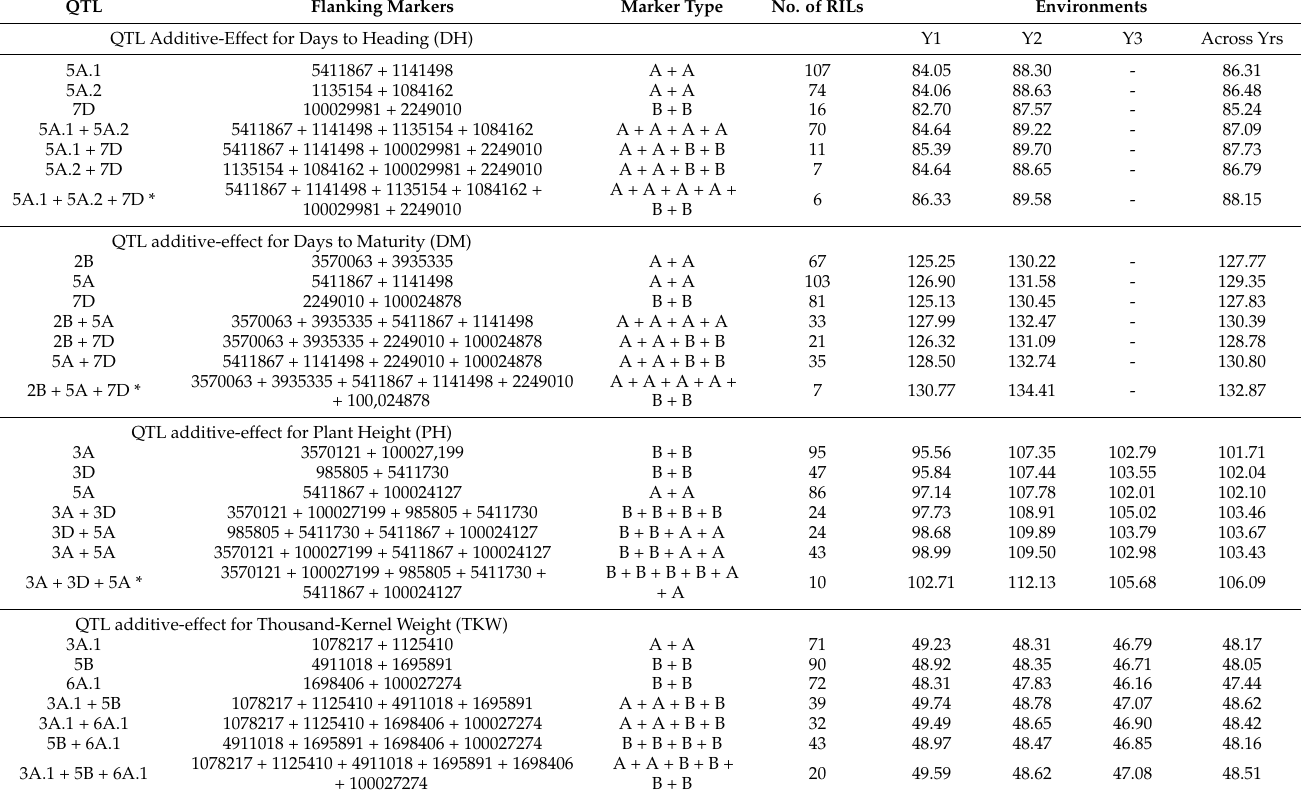
Table 5. The Phenotypic effect on combining high-effect and stable QTLs of DH, DM, PH, TKW and